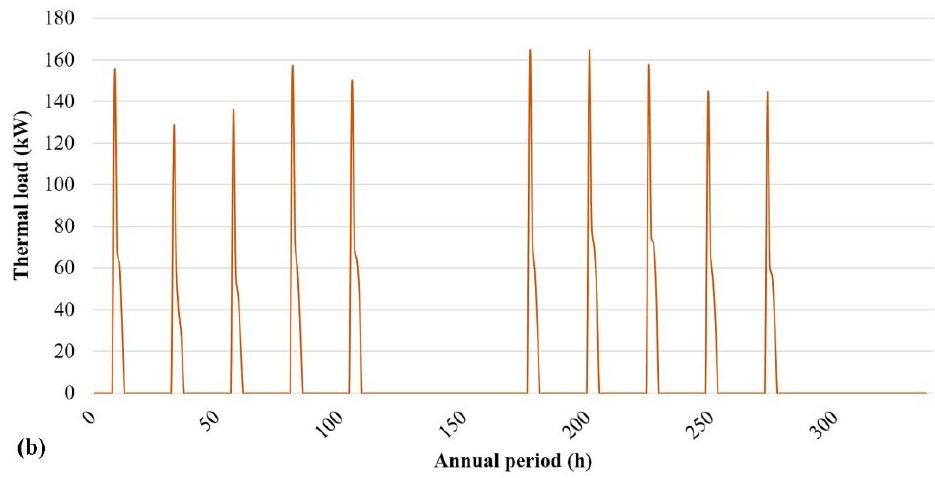
Figure 8. Heating loads fluctuation for the first two weeks of ( a ) January and ( b ) December.